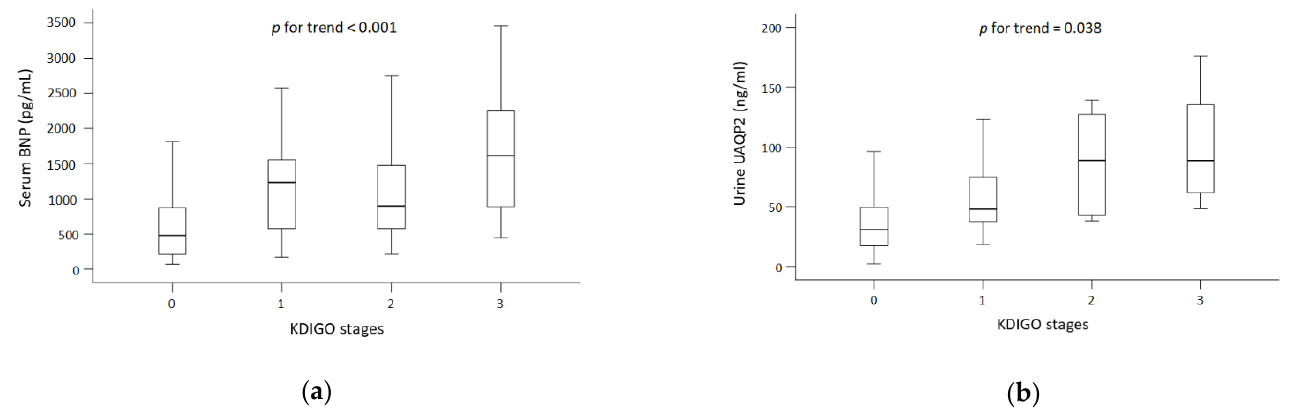
Figure 1. Levels of serum BNP ( a ) and urine AQP2 ( b ) across KDIGO stages. Abbreviations: AQP2,